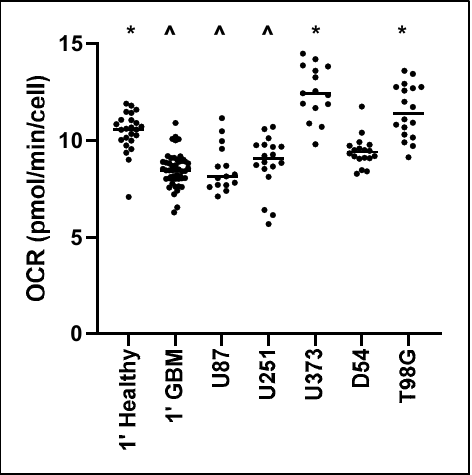
Figure 1. Baseline Oxygen Consumption Rate (OCR) for primary healthy cells and primary Glioblastoma (GBM) cells, and GBM cell lines. Cell populations of primary healthy mixed neural cells, primary GBM cells, and GBM cell lines, were isolated and mitochondrial metabolic activity was measured as changes in OCR. Data presented represent the mean and individual data points. Biological replicates for cell lines ( n = 5), primary healthy cells ( n = 8), and primary GBM tumour cells ( n = 13); with technical triplicates. * Significant di ff erence from primary glioblastoma control (1 (cid:48) GBM) ( p ≤ 0.05). ˆ Significant di ff erence from primary healthy mixed neural control (1 (cid:48) Healthy) ( p ≤